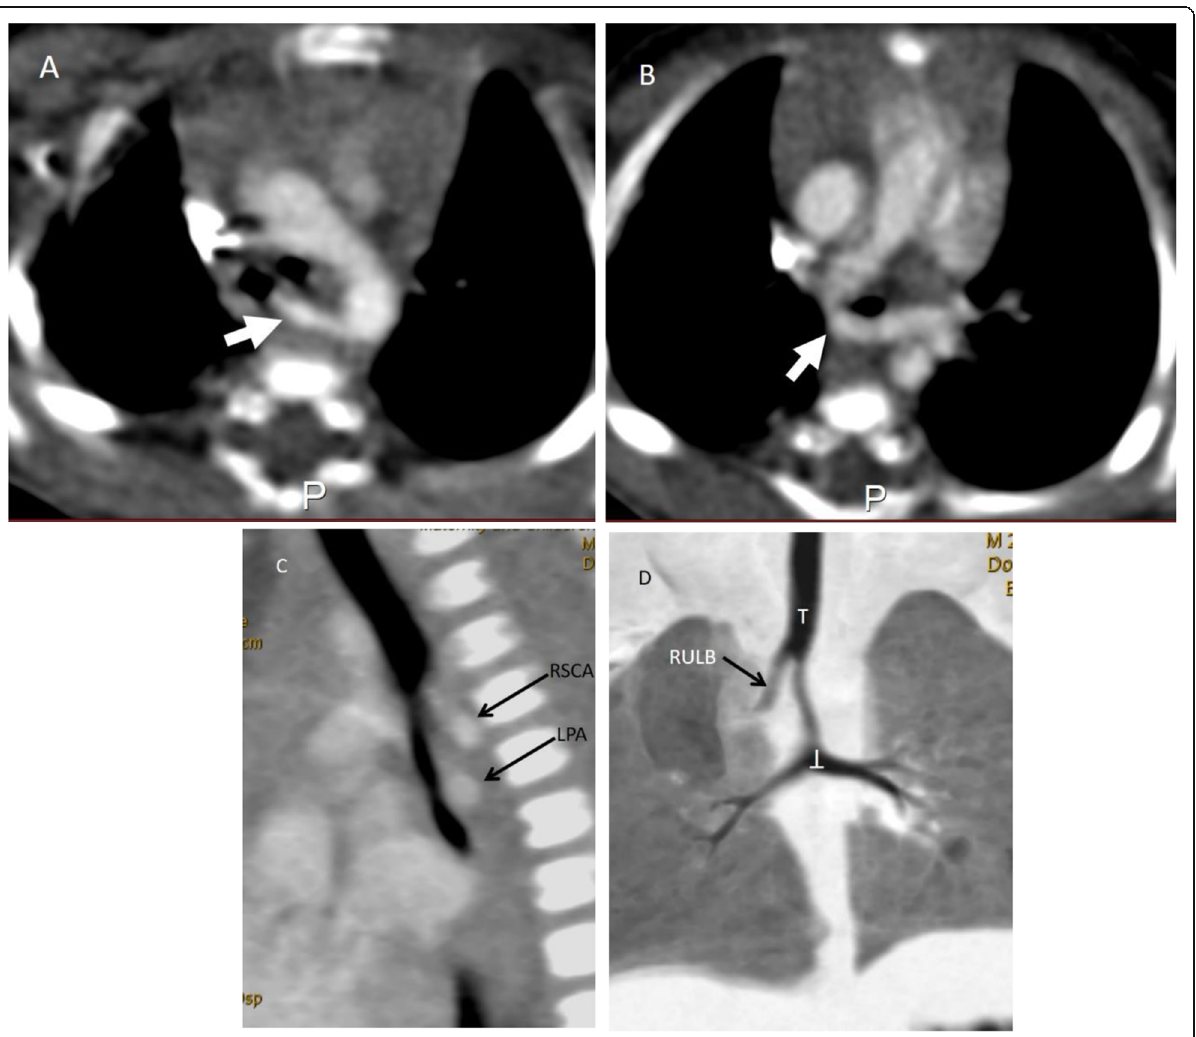
Fig. 8 An 8-day-old girl with respiratory distress. She has an aberrant right SCA (arrow in a ) and aberrant left pulmonary artery that arises from the right pulmonary artery (arrow in b ). The aberrant LPA passes between the trachea and the esophagus. Sagittal reformat MinIP image ( c ) shows the aberrant RSCA and LPA as well as the long tracheal stenosis. d MinIP image shows right upper lobe bronchus (RULB) arising from trachea (bronchus suis). Distal to the take-off of RULB, the trachea appears narrow with low T-shaped carina (inverted T) caused by the horizontal orientation of the left main bronchus and the bronchus intermedius. Comments: Tracheal stenosis was not limited to the aberrant LPA denoting congenital stenosis rather than localized compression by the aberrant LPA. The anesthesiologist should be aware of the tracheal RULB as it poses risk during ETT introduction. So, we can also say that CT scan is not only important for surgical planning but also to alert anesthesiologists about potential complications caused by the airway